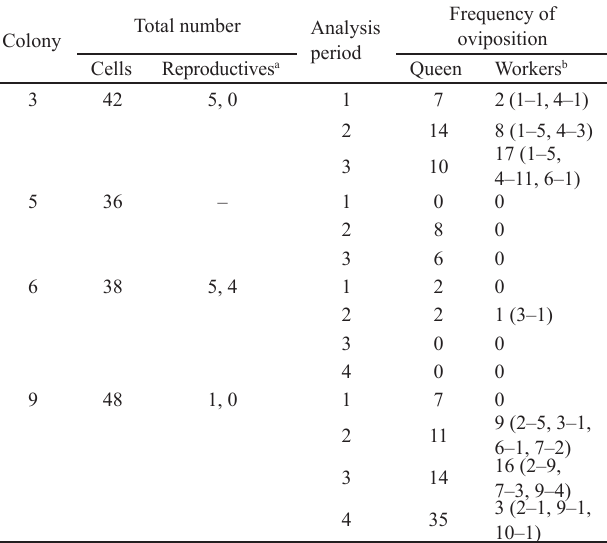
Table 2. Colony size and eggs laid.